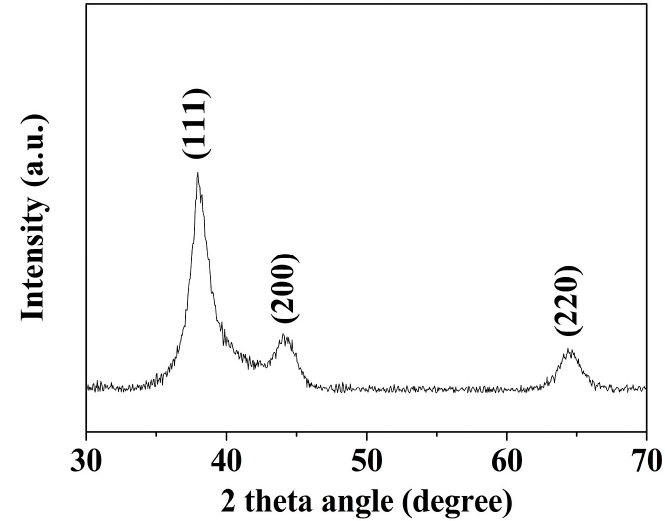
Figure 2. X-ray diffraction (XRD) pattern of silk-like ultralong and ultrathin nanowires.